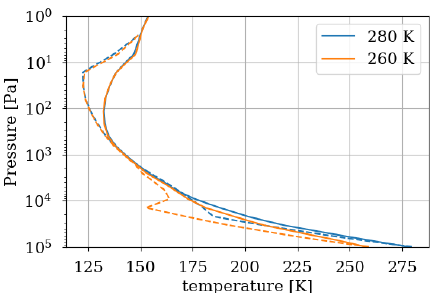
depending on the surface temperature. Results Figure 12. F CH 4 of the 3D model surface and annual average (solid and mark for snowball) as well as the 1D model (dashed). Surface: CH 4 = 10 − 4 and O 2 = 10 − 5 .